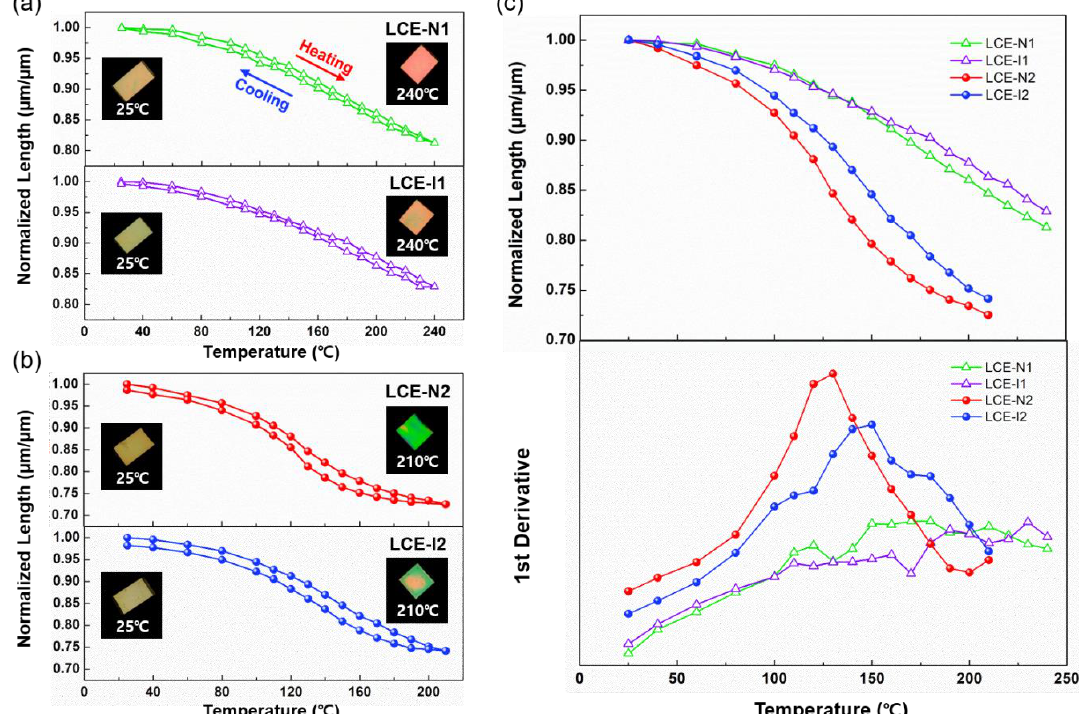
Figure 6. Reversible thermal actuation of planarly aligned LCEs (changes in length during second heating and cooling observed under a POM): ( a ) LCE-N1 (top) and LCE-I1 (bottom); ( b ) LCE-N2 (top)